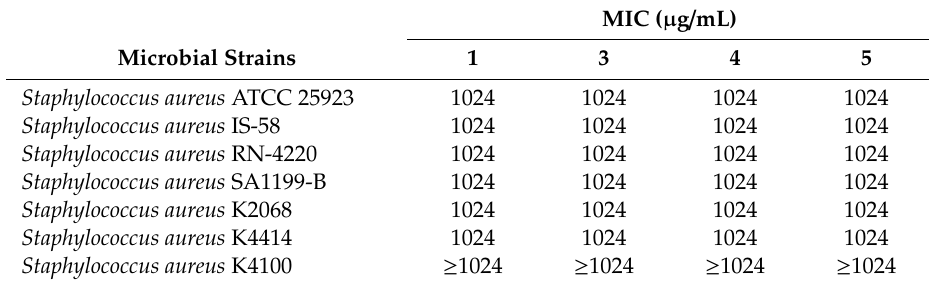
Table 3. Geometric means of MIC values found for chalcones isolated from the flowers of Arrabidaea brachypoda against S. aureus strains overexpressing e ffl ux pump genes, except ATCC 25,923 that is a standard strain (All values represent the geometric mean of three simultaneous experiments). MIC ( µ g / mL) Microbial Strains